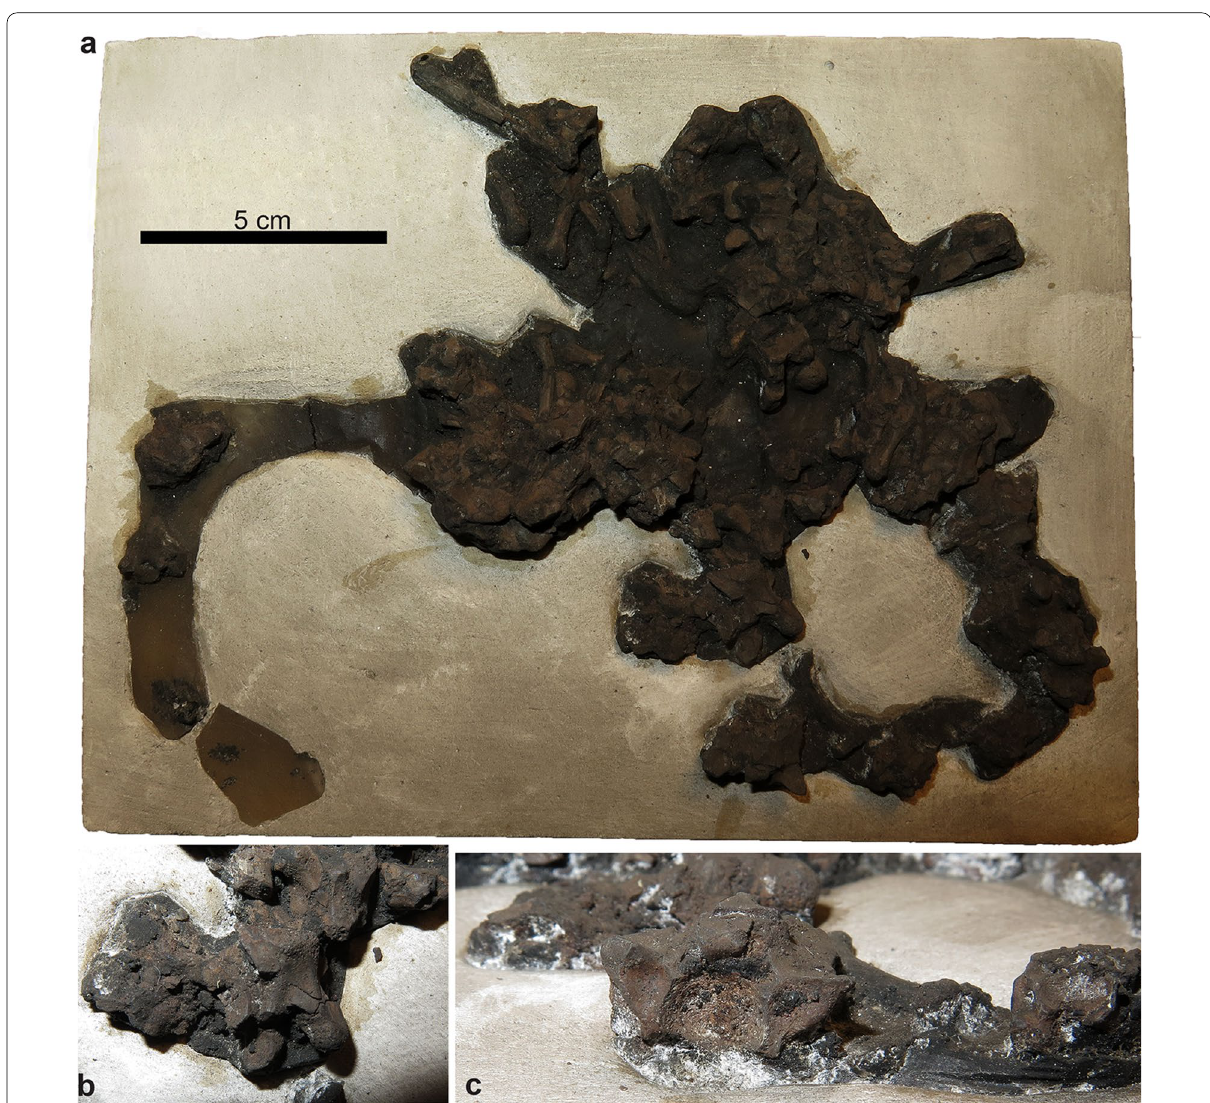
Fig. 26 Palaeopython ceciliensis from quarry Cecilie IV, Geiseltal: a several articulated and disarticulated trunk vertebrae and ribs on a matrix (GMH Ce IV-5858-1933); b , c close ups of the same